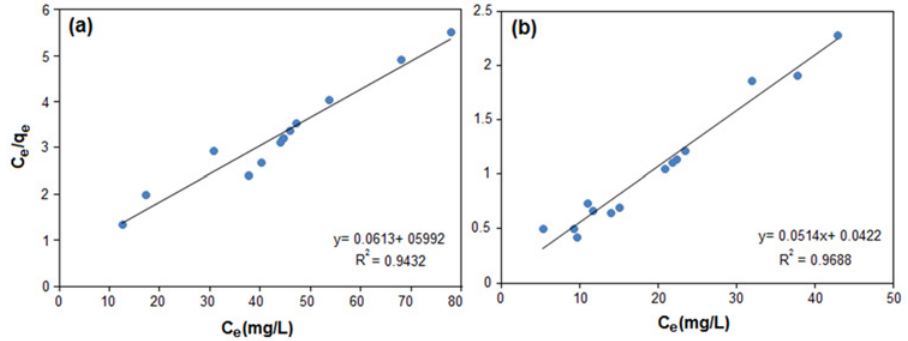
Fig 6. Langmuir isotherm plots of the biosorption of Cu(II) (a), and Pb(II) (b) by RS/Fe 3 O 4 -NCs.